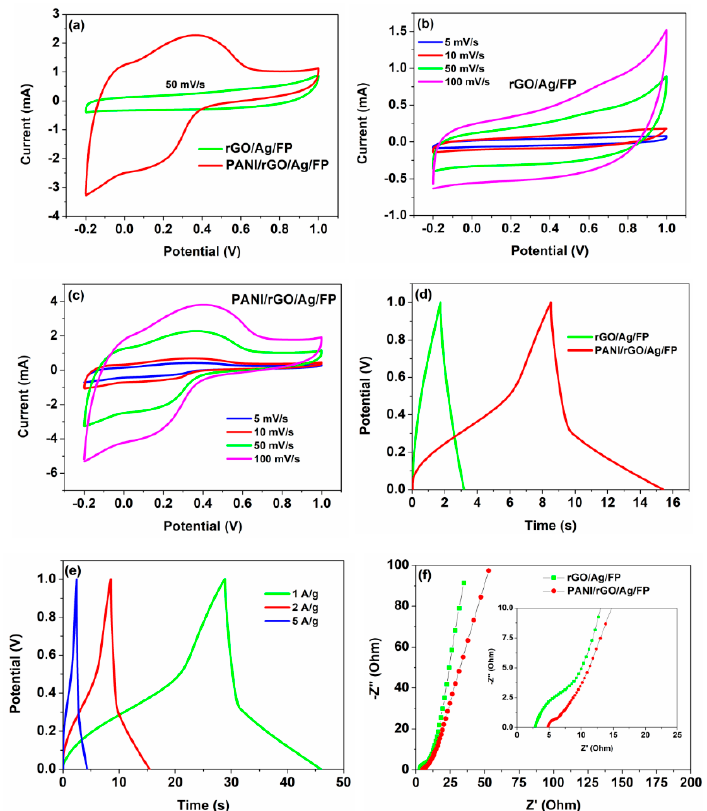
Figure 5. ( a ) Cyclic voltammetry (CV) curves of the rGO/Ag/FP and PANI/rGO/Ag/FP electrodes under the scanning rate of 50 mV/s; ( b , c ) CV curves of the rGO/Ag/FP and PANI/rGO/Ag/FP electrodes under different scanning rates, respectively; ( d ) galvanostatic charge-discharge (GCD) curves of rGO/Ag/FP and PANI/rGO/Ag/FP electrodes at the current density of 2 A/g; ( e ) GCD curves of PANI/rGO/Ag/FP electrode at different current densities; ( f ) Nyquist plots of rGO/Ag/FP and PANI/rGO/Ag/FP electrodes.